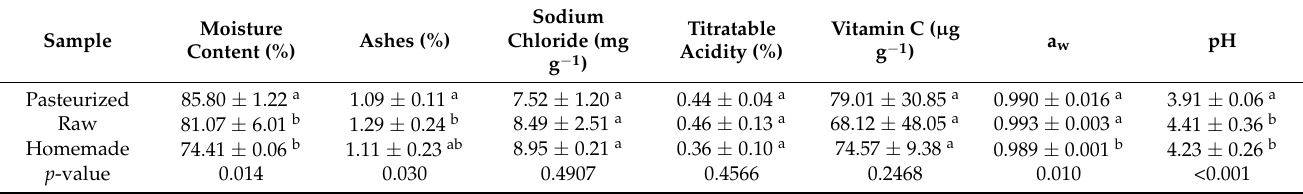
Table 1. Physical-chemical parameters of salmorejo samples (mean ±